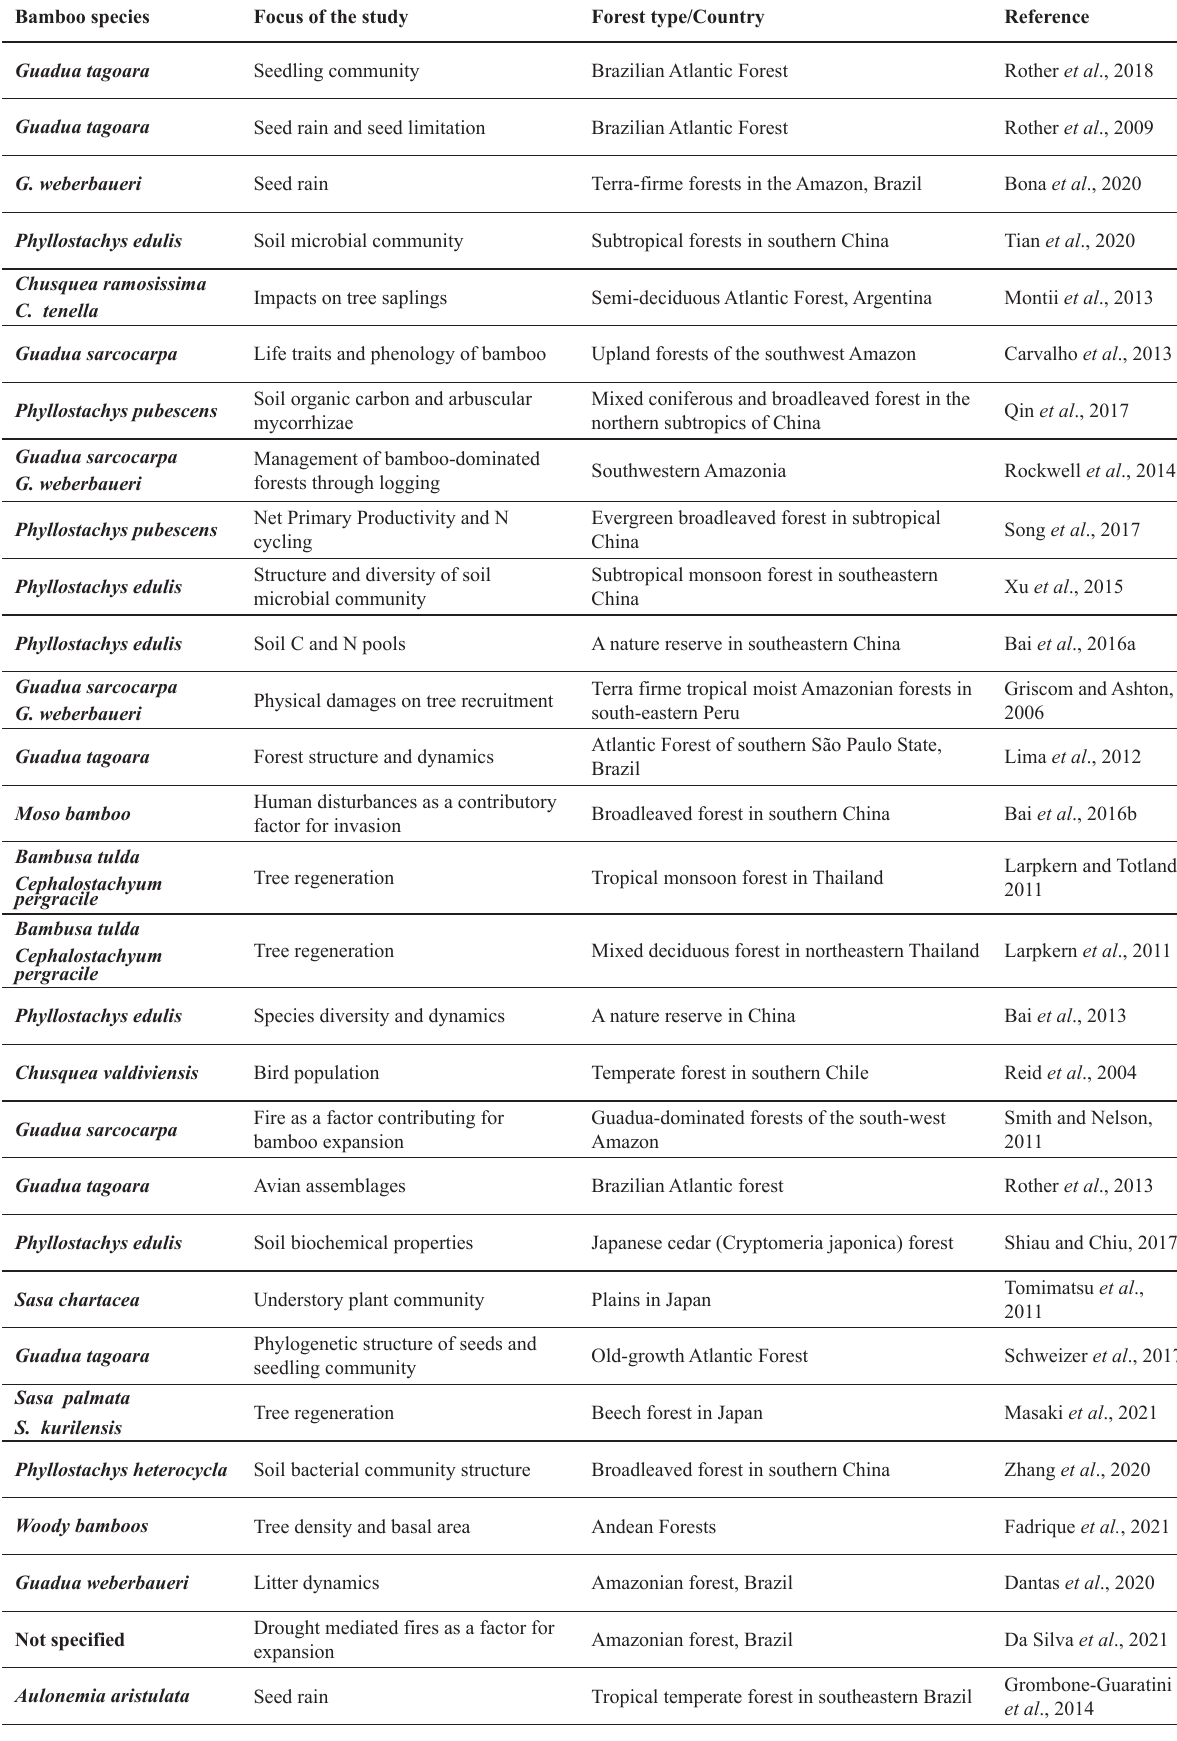
Table 1: A list of literature published globally on native bamboo invaders during the past decade. Bamboo